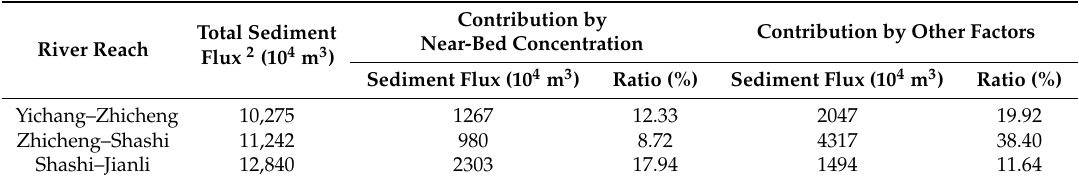
Table 4. Contribution by various factors on sediment flux 1 .